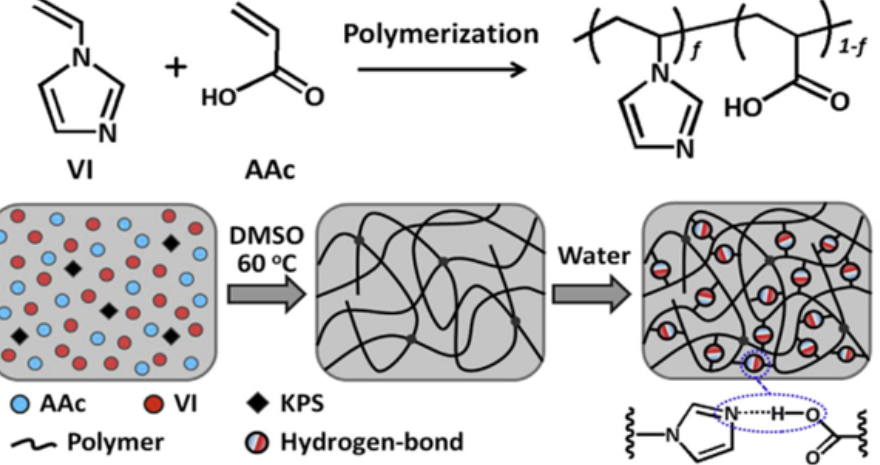
Figure 9. Preparation mechanism of 1-vinylimidazole-co-acrylic acid (VI-co-AAc) gels. (Reprinted/adapted with permission from Ref. [56], 2017, Ding et al.).